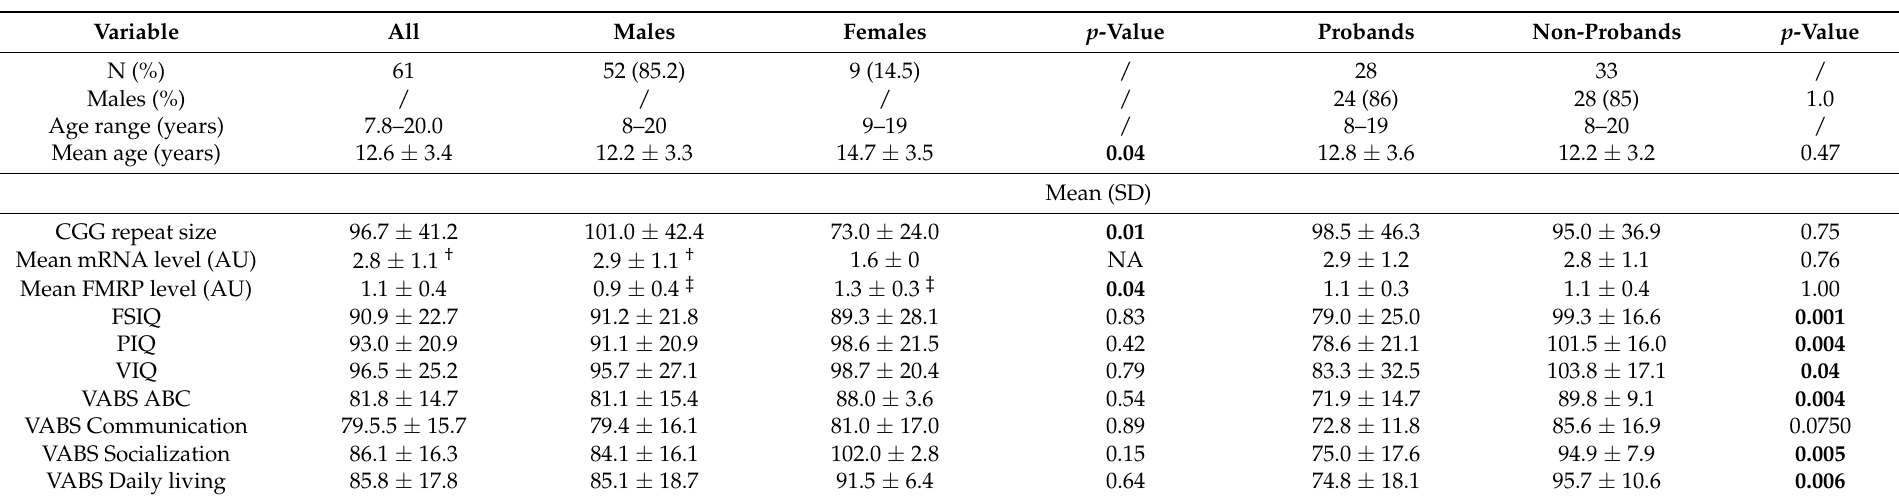
Table 1. Descriptive data of study